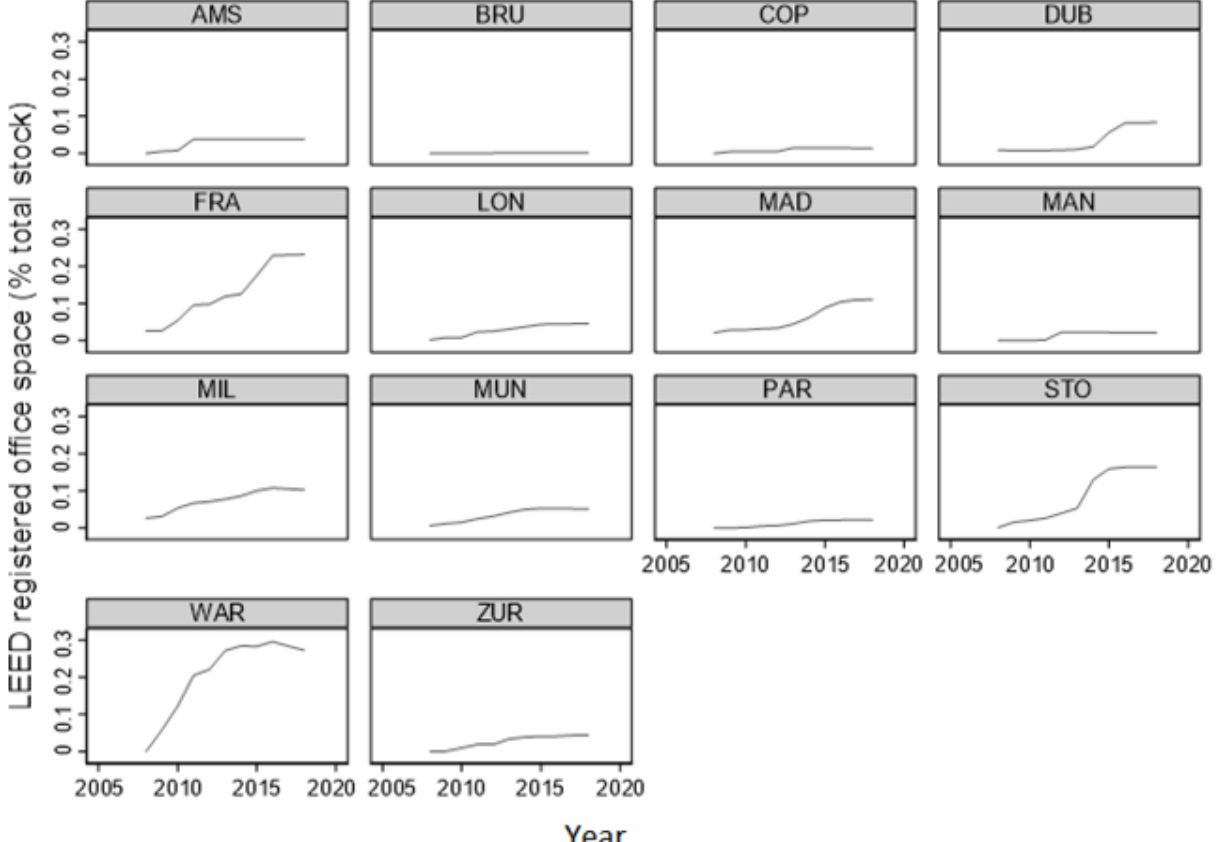
Figure 5. Adoption of LEED in selected European office markets (2008–2018). The differences between the European cities in the adoption of LEED certification (or green building adoption in general for that matter) may be related to various factors. The diffusion of green technologies and the adoption of green building certifications may be driven by environmental policies or regulations, climate and weather conditions, or salient socioeconomic conditions that vary between locations and change over